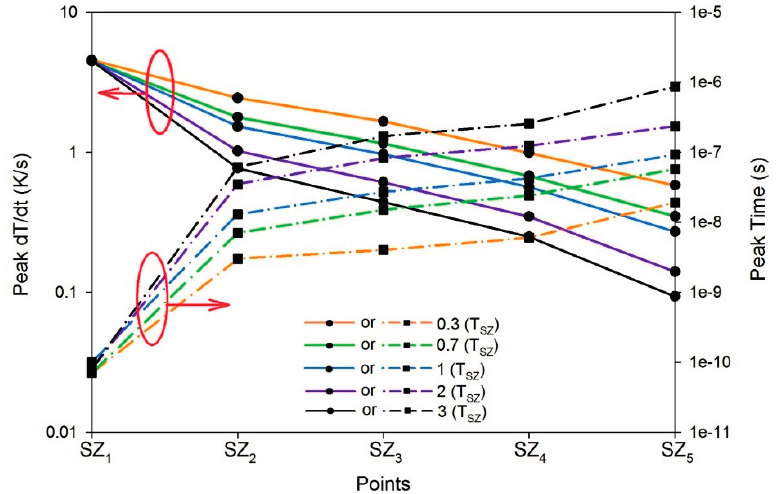
Figure 10. The peak temperature variation rate and the peak time of the maximum temperature variation rate at points SZ 1 to SZ 5 under a single ZnO layer 0.3 to 3 μ m thick.